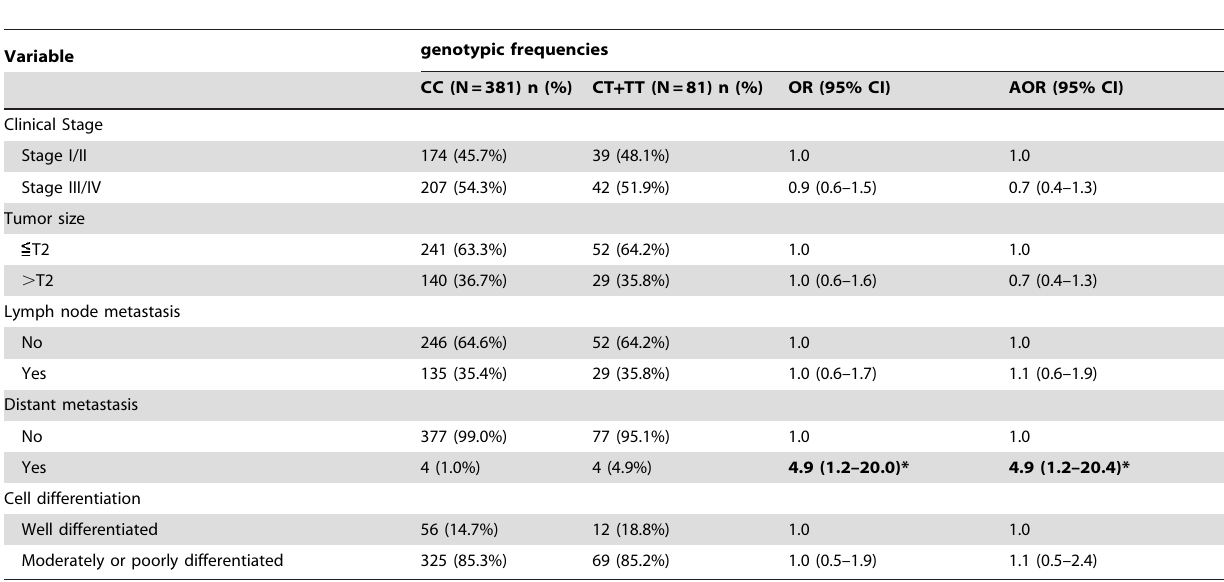
Table 5. Distribution frequencies for clinical status and NFKBIA 2 519 genotype in 462 patients with OSCC.